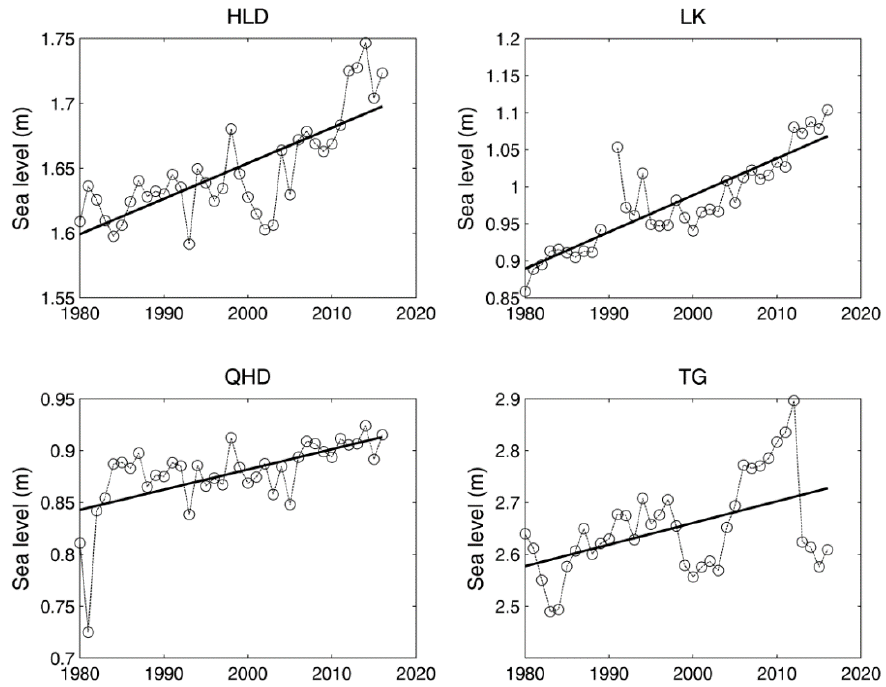
Figure 2. Mean sea level (curve line) and fitted linear trends (straight line) at four tide gauges: HLD (Huludao), LK (Longkou), QHD (Qinhuangdao) and TG (Tanggu).